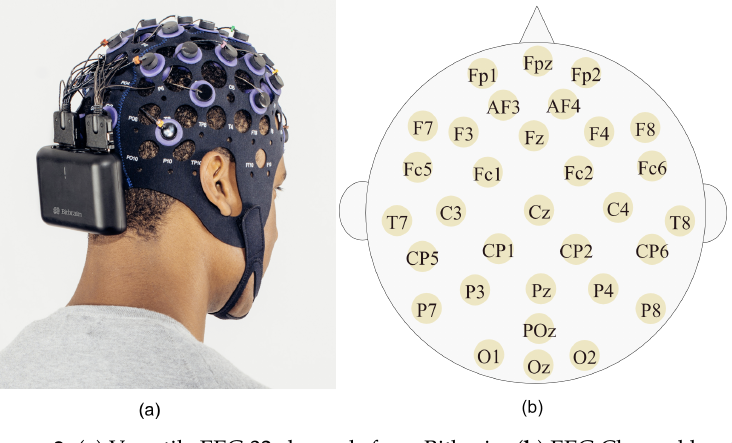
Figure 2. ( a ) Versatile EEG 32 channels from Bitbrain. ( b ) EEG Channel